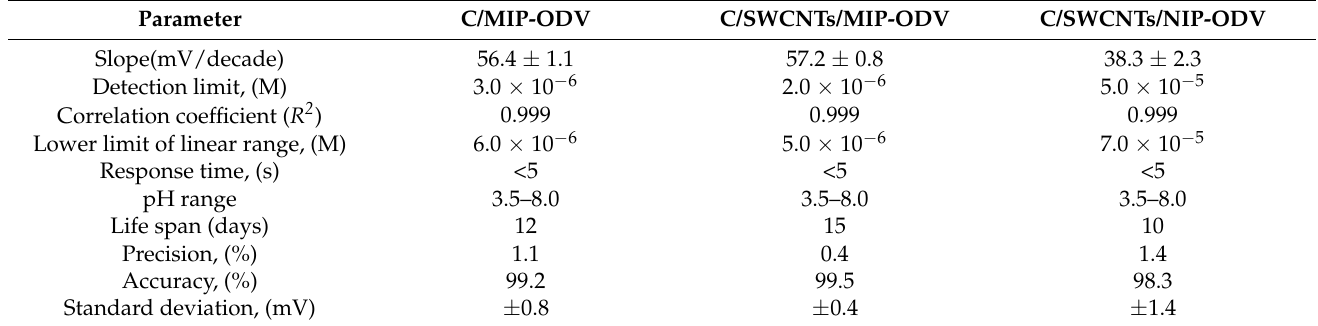
Table 2. Analytical performance of the presented electrodes in 10 mmol/L phosphate buffer, pH